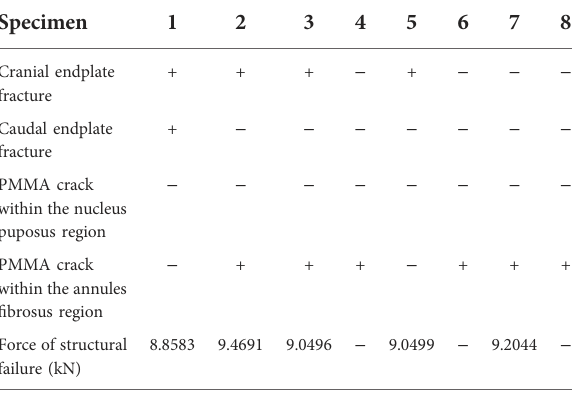
TABLE 4 Structural changes of specimens subjected to compression failure tests.